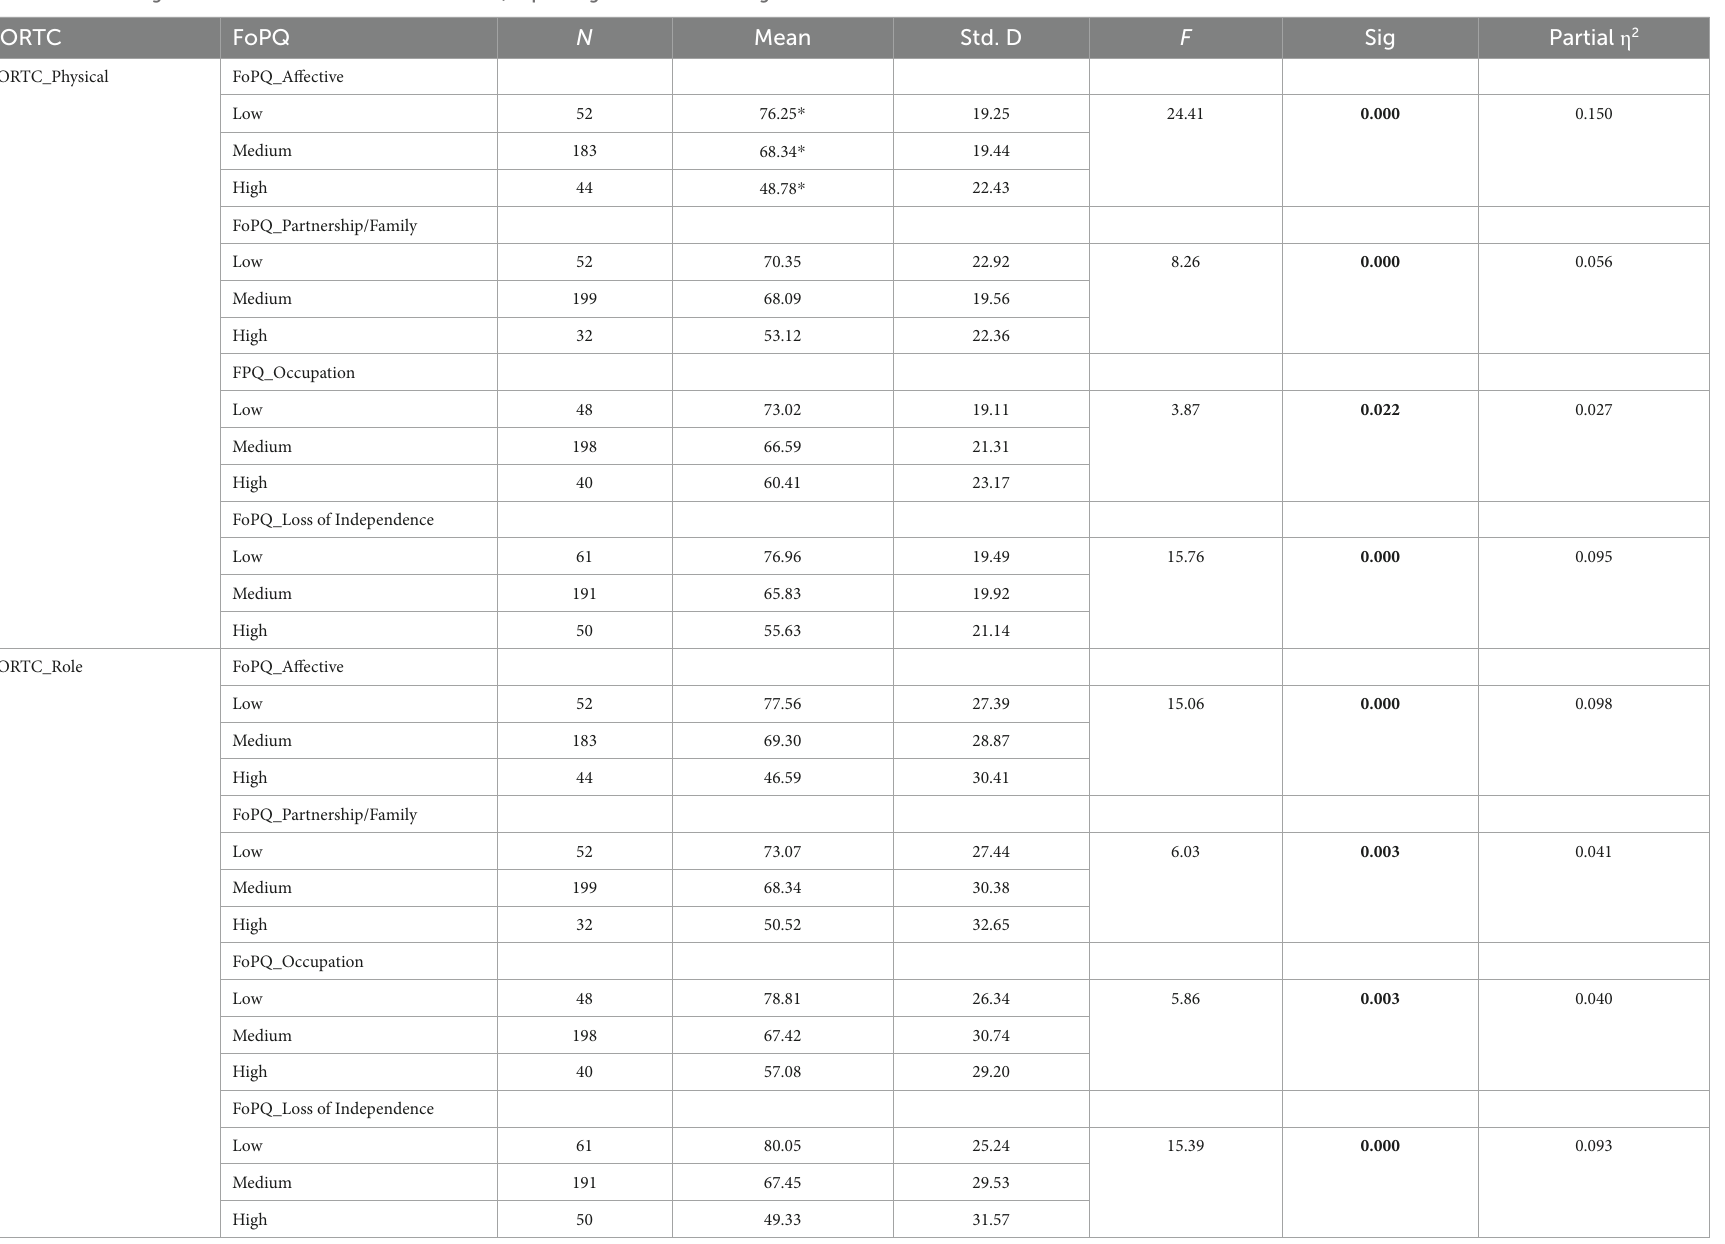
TABLE 2 Multivariate general linear models for EORTC subscales, depending on low-medium-high levels of FoP subscales. EORTC FoPQ N Mean Std. D F Sig Partial η